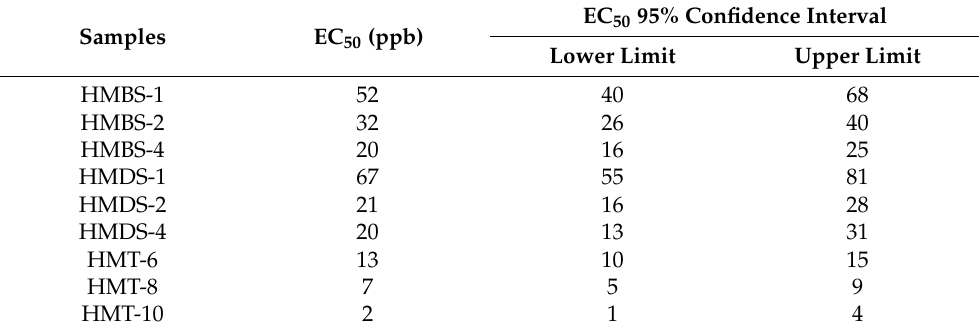
Table 2. The half-maximal effective concentration, EC 50 values for hexaconazole-micelle nanodelivery systems prepared at different concentrations and different surfactant types against G. boninense after 7 days incubation.